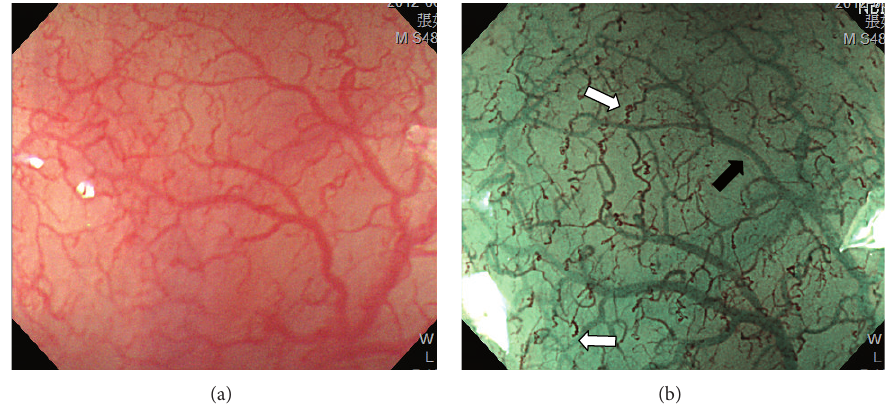
Figure 1: (a) Magnifying endoscopy under white-light imaging shows microvasculature of the normal esophagus. (b) Magnifying endoscopy under narrow-band imaging improves visualization of the reddish-brown superficial vessels (white arrow, Inoue’s classification of intraepithelial papillary capillary loops type II) and the cyanic hue deeper vessels (black